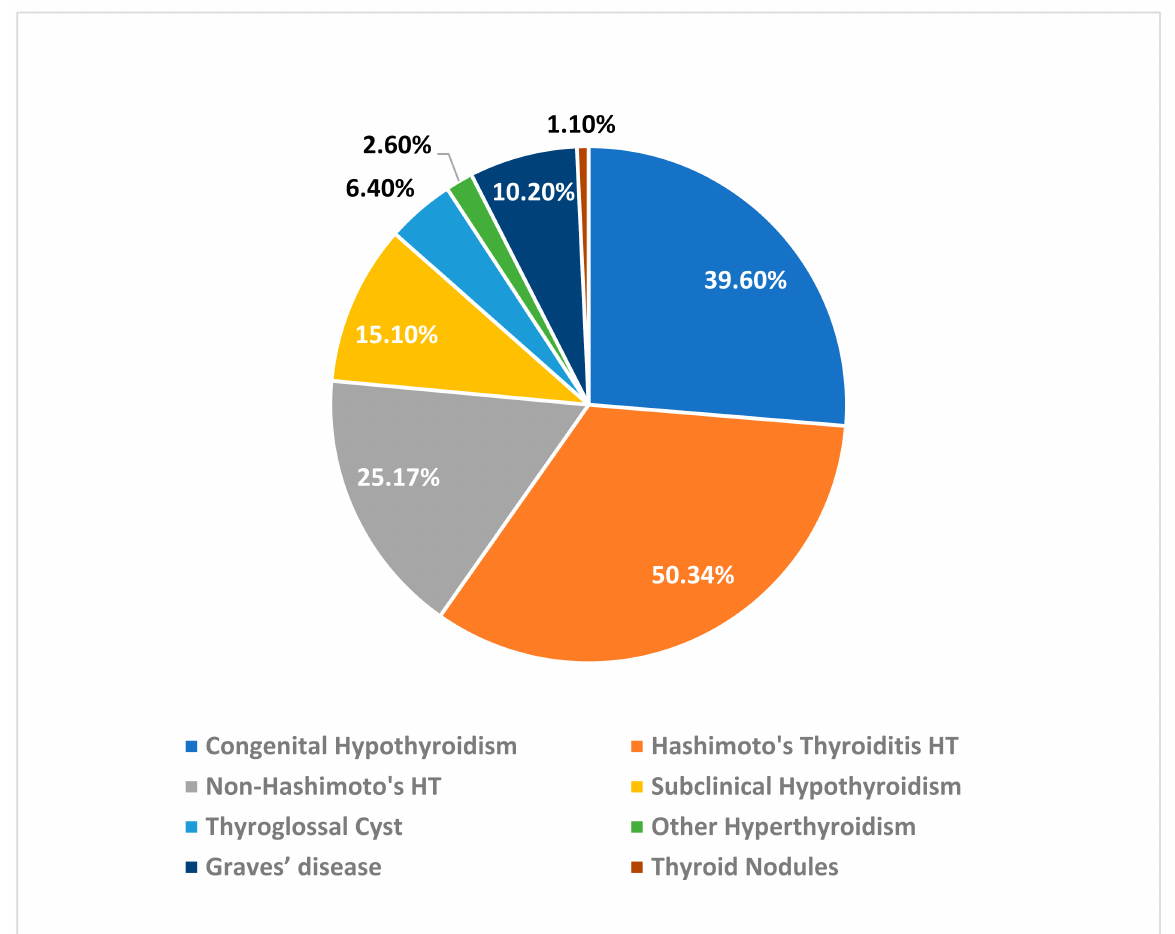
Figure 1. The percentage of each thyroid disorder among all affected pediatric patients. HT: hypothyroidism. The female patients, most have Hashimoto’s thyroiditis and Congenital Hypothy- roidism, and they were found to be equal in number The presentations of patients with Hashimoto’s thyroiditis were mainly hypothyroidism symptoms in half of them, goiter in one-fourth, and by screening test due to family history in one-fourth, we had only one patient who had history suggestive of hyperthyroidism and confirmed by thyroid function tests. In the other hand, most male patients were diagnosed with Congenital Hypothy- roidism and non-Hashimoto’s hypothyroidism, followed by Subclinical Hypothyroidism, and none of the male patients were diagnosed with Hyperthyroidism (Figure